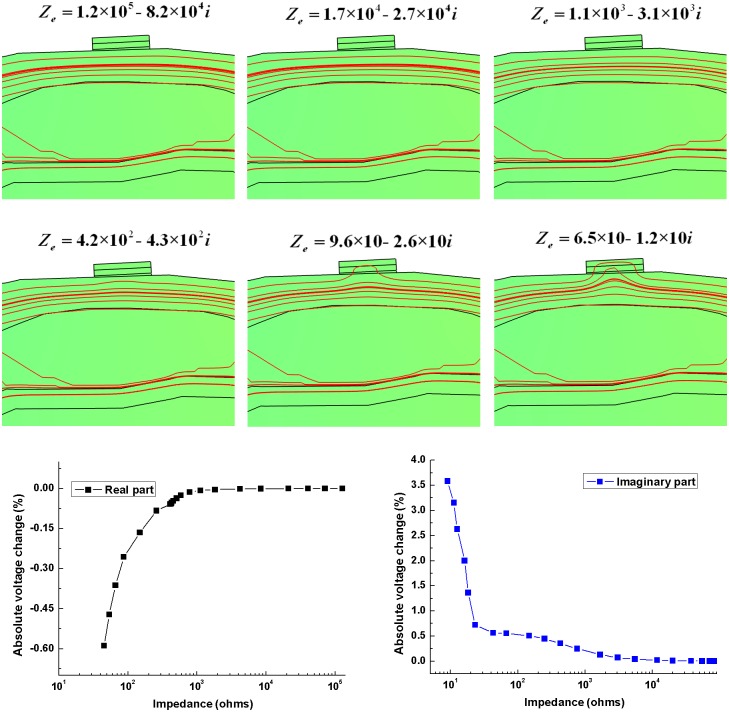
The current distribution beneath Electrode 5 with different contact impedances and the absolute voltage change in Electrode 5.